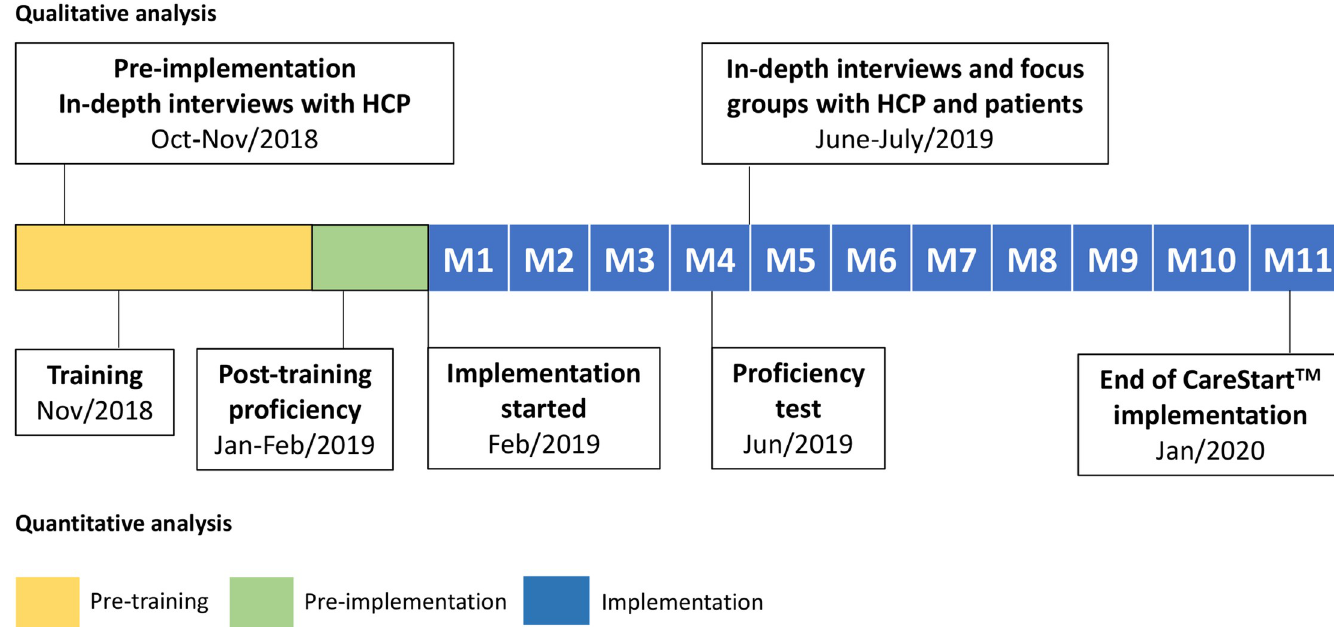
Fig 2. Timeline of events. Timeline of events is shown consisting of three phases: 1) pre-training (before any study intervention, yellow), pre-implementation (after training but before implementation, green), and implementation period (actual implementation of the test, blue). Each M corresponds to a month of